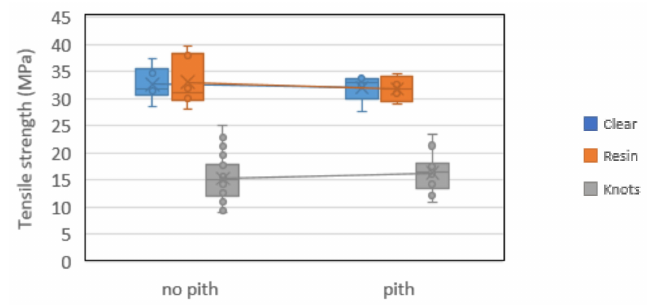
Figure 31. Box plot of tension strength—with and without